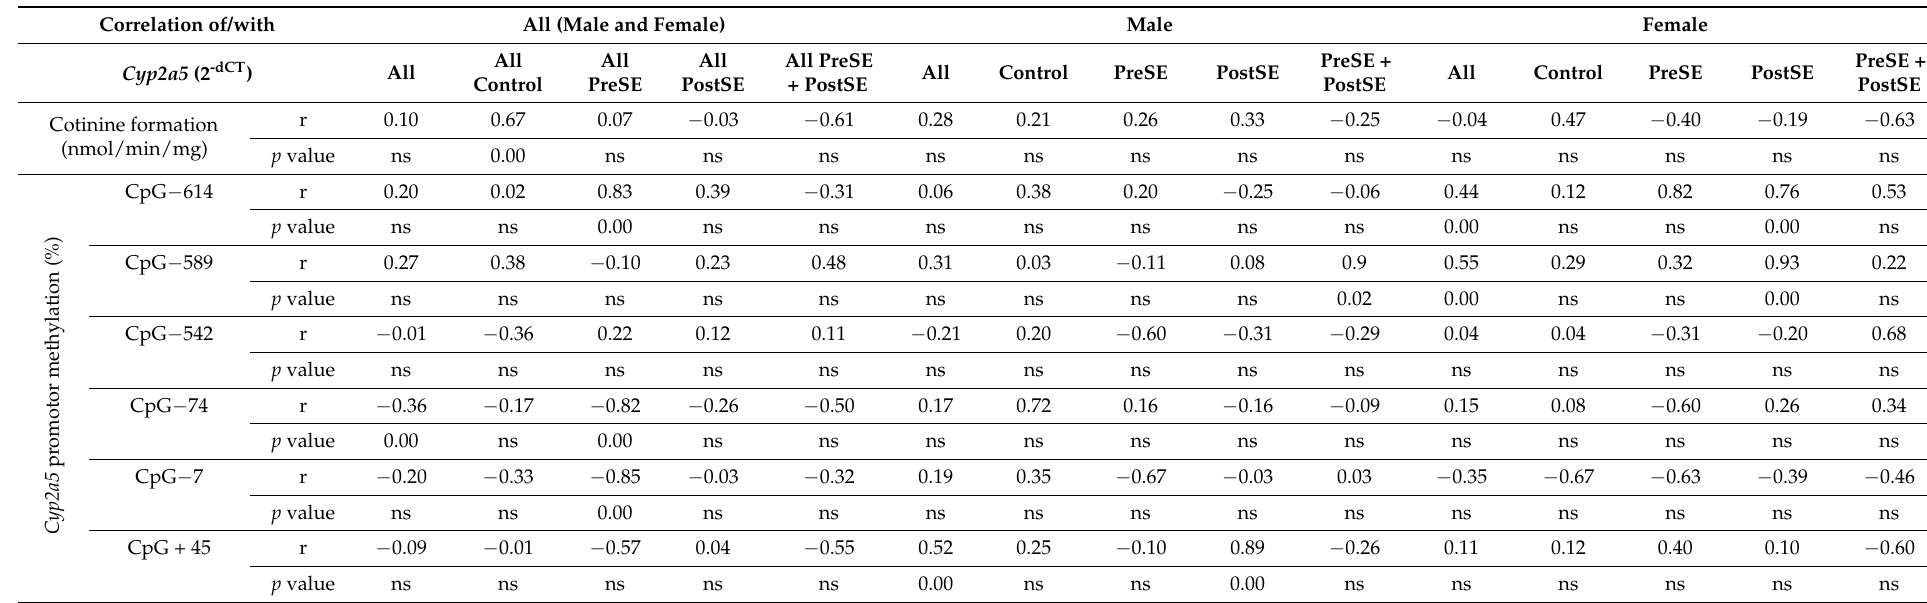
Table 1. Correlations between cotinine levels, Cyp2a5 mRNA expression and promoter methylation in liver. Correlation